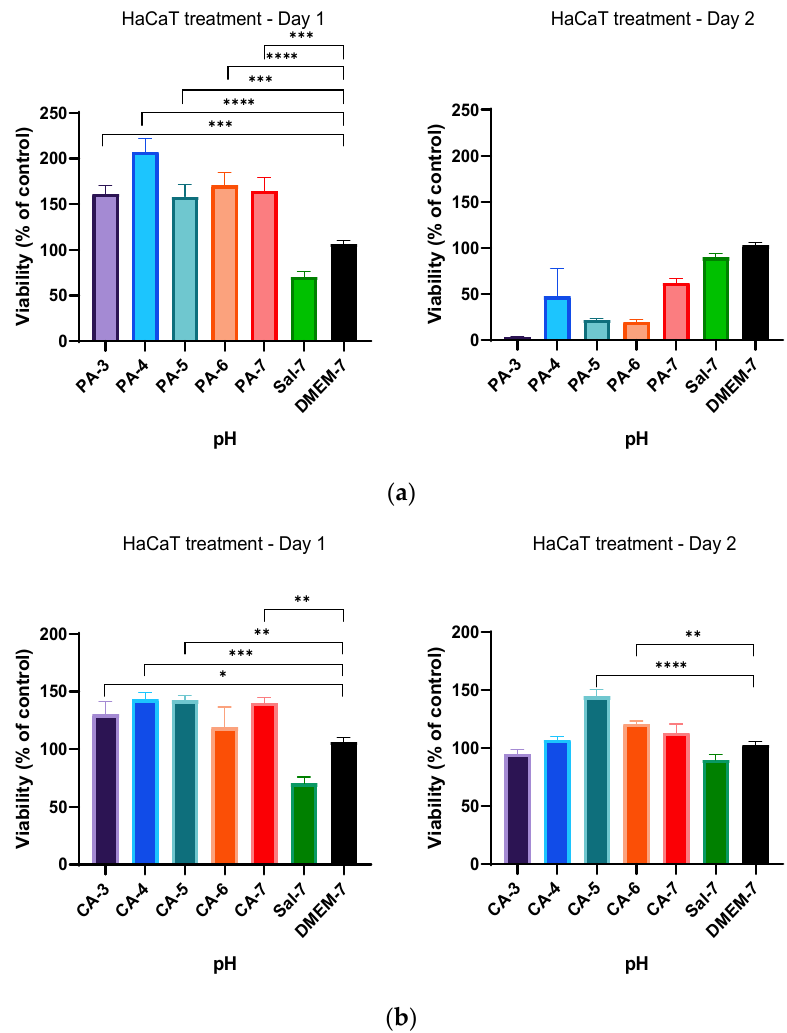
Figure 2. Percentage viability of HaCaT cells when treated with ( a ) 0.01 M phosphoric acid (PA) buffer solutions, with pH ranges from 3 to 7 and ( b ) 0.01 M citric acid (CA) buffer solutions, with pH adjusted to 3, 4, 5, 6 and 7. HaCaT cells tolerated well within an acidic pH range of 3 to 7 for 24 h. Each bar represents the mean ± standard deviation. * p < 0.05, ** p < 0.01, *** p < 0.005 and **** p < 0.001 indicates that the results obtained were statistically significant from those of the control group (DMEM-7).